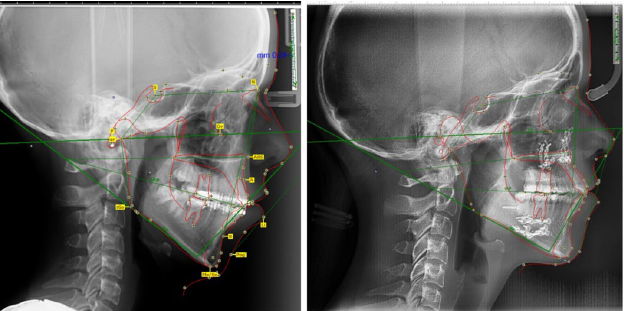
Figure 5. Cephalometric tracing using Onixceph software before ( left ) and after orthognathic surgery ( right ).